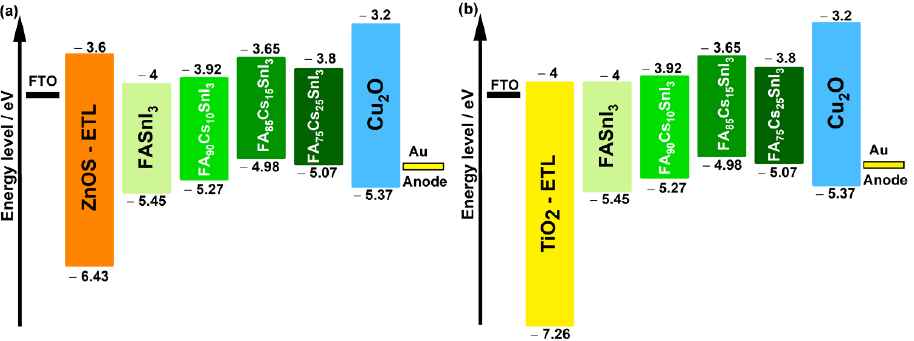
Figure 1. Schematic diagram of lead-free FA 1−x Cs x SnI 3 -based PSC structure. The simulation was performed at a temperature of 300 K under standard illumination of 1000 W/m 2 , and an air mass of AM 1.5 G. As shown in the figure, the absorber layer was placed between the HTL and ETL layers. As a front contact and back metal, Fluorine- doped tin oxide (FTO) and back metal gold (Au) were used, respectively. For every structure, the considered HTL was Cu 2 O, while the ETL material alternated between ZnOS and TiO 2 . A comparison between the two latter materials was performed. Figure 2 illustrates the energy level diagram of the considered materials in the device structure. Figure 2a,b include TiO 2 and ZnOS as ETL layers, respectively.